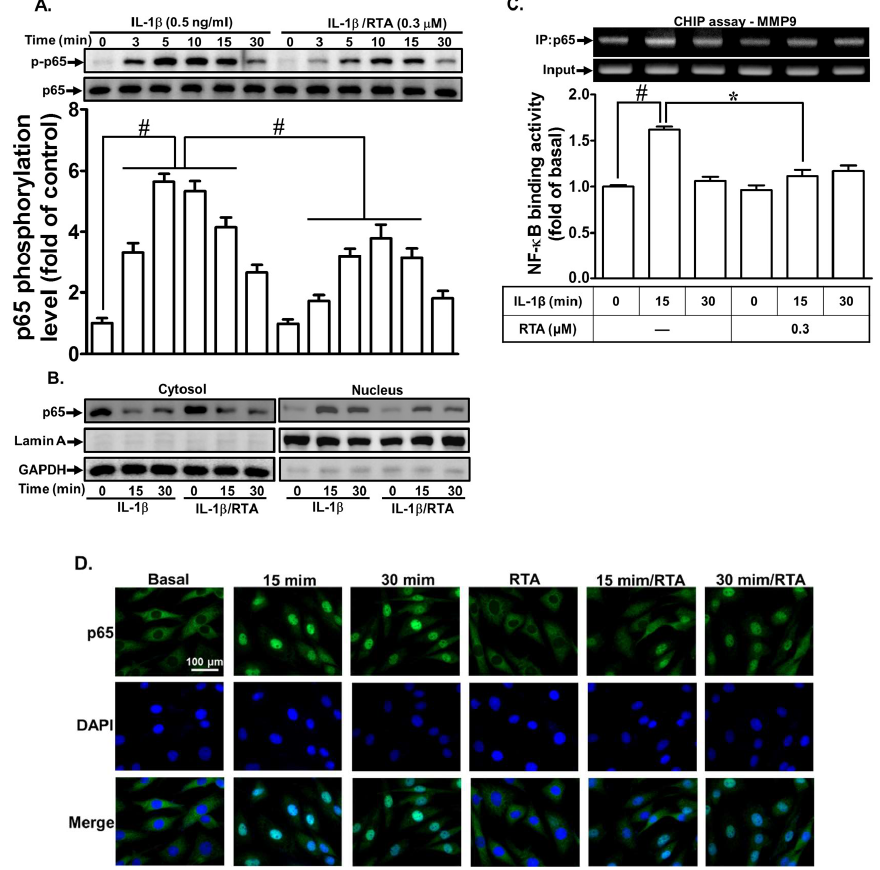
Figure 6. RTA 408 attenuates the IL-1 β -induced proMMP-9 expression via down-regulating NF- κ B activities. ( A ) Cells were pretreated with RTA 408 (0.3 µ M) for 4 h, and then incubated with IL-1 β (0.5 ng / mL) for the indicated time intervals (3, 5, 10, 15, and 30 min), the phosphorylation of p65 was detected by western blot. ( B ) Cells were pretreated with or without RTA 408 (0.3 µ M) for 4 h and incubated with 0.5 ng / mL IL-1 β for the indicated time intervals. The cytosol and nucleus fraction were prepared, and the levels of p65 translocation were analyzed by western blot. ( C ) Cells were pretreated with / without RTA 408 (0.3 µ M) for 4 h, and then incubated with IL-1 β (0.5 ng / mL) for the indicated time intervals (15 and 30 min), ChIP assay was performed by using a specific antibody of p65. ( D ) The p65 translocation was confirmed by immunofluorescence staining. Data analysis and processing are described in the section “Statistical Analysis of Data.” * indicates p < 0.05; # indicates p < 0.01, as compared between the indicated groups. The figure represents one of three individual